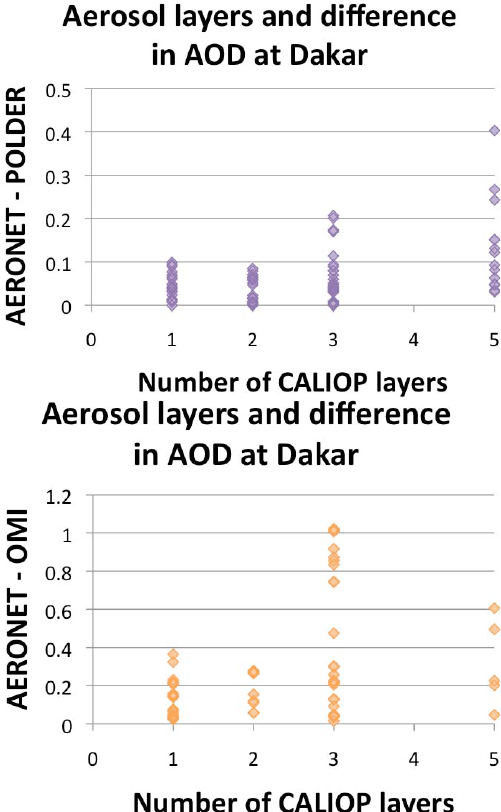
Fig. 10. An example of aerosol analysis using MAPSS: differences (deltas) in means of AOD between ground-based and spaceborne observations in 2003–2010 over Dakar, plotted against the number of aerosol layers detected over this location. Data were screened using the following set of QA flags: OMI QA=0, POLDER (Ocean) Inversion QA >